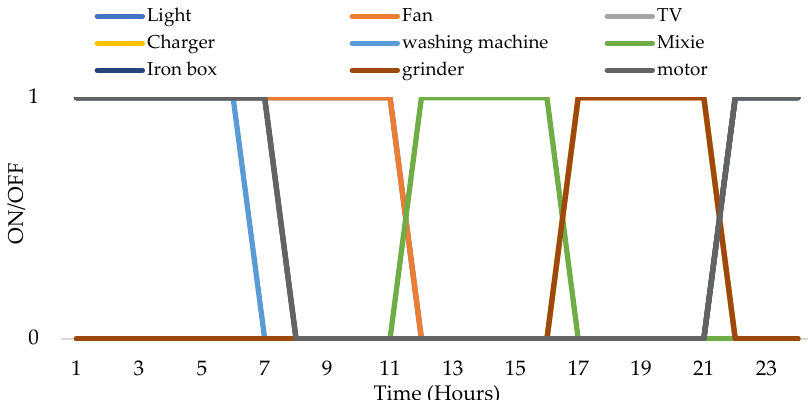
Figure 8. ON/OFF period of individual appliances for residential area.